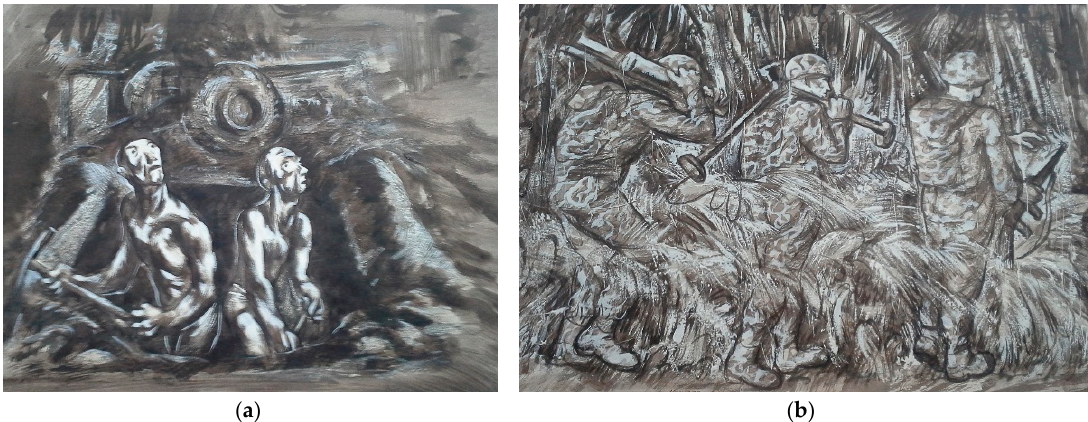
Figure 9. The Rendova sketches reflect stylistic experimentation, as Cook attempted a more expressionistic approach: ( a ) Howard Cook, Two Men in a Foxhole , 1943, mixed media on paper. Permanent Collection of the Roswell Museum and Art Center, Gift of the Artist, 1973.031.0223. Used with permission. ( b ) Howard Cook, Jungle Camouflage , 1943, mixed media on paper. Permanent Collection of the Roswell Museum and Art Center, Gift of the Artist, 1973.031.0229. Used with